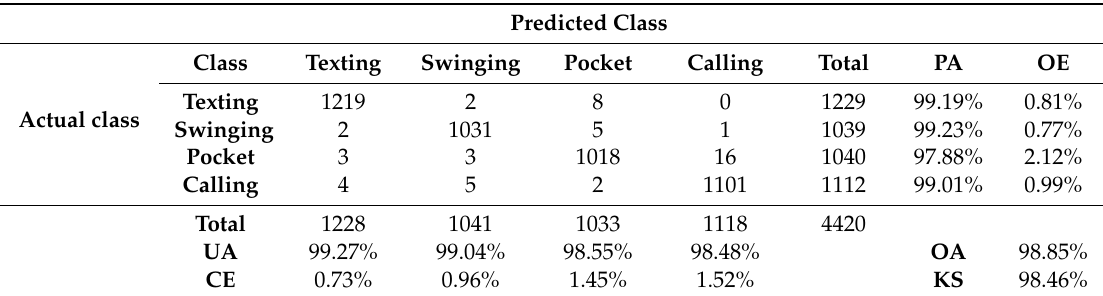
Table 3. Confusion matrix of pose recognition with seven categories.